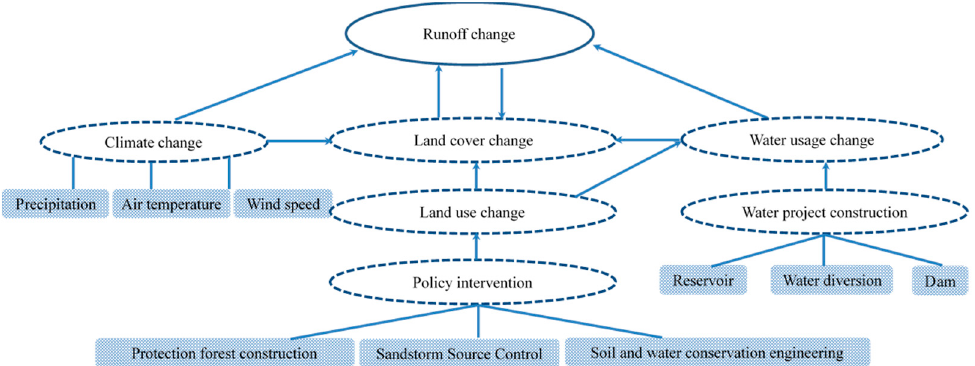
Figure 2. Impact of climate change and human activities on runo ff